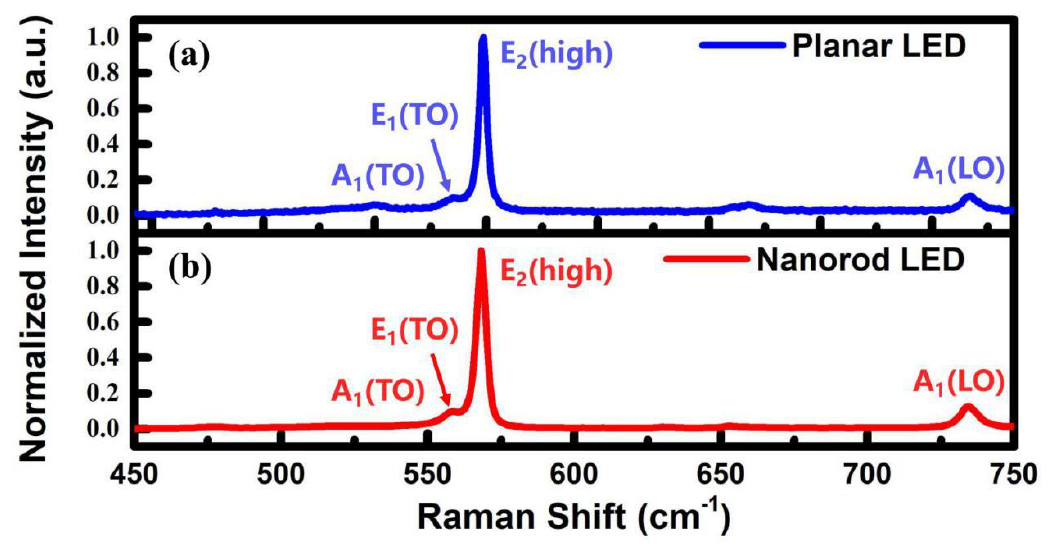
Figure 3. The normalized Raman spectrum of the GaN/ β -Ga 2 O 3 ( a ) planar and ( b ) nanorod LED.